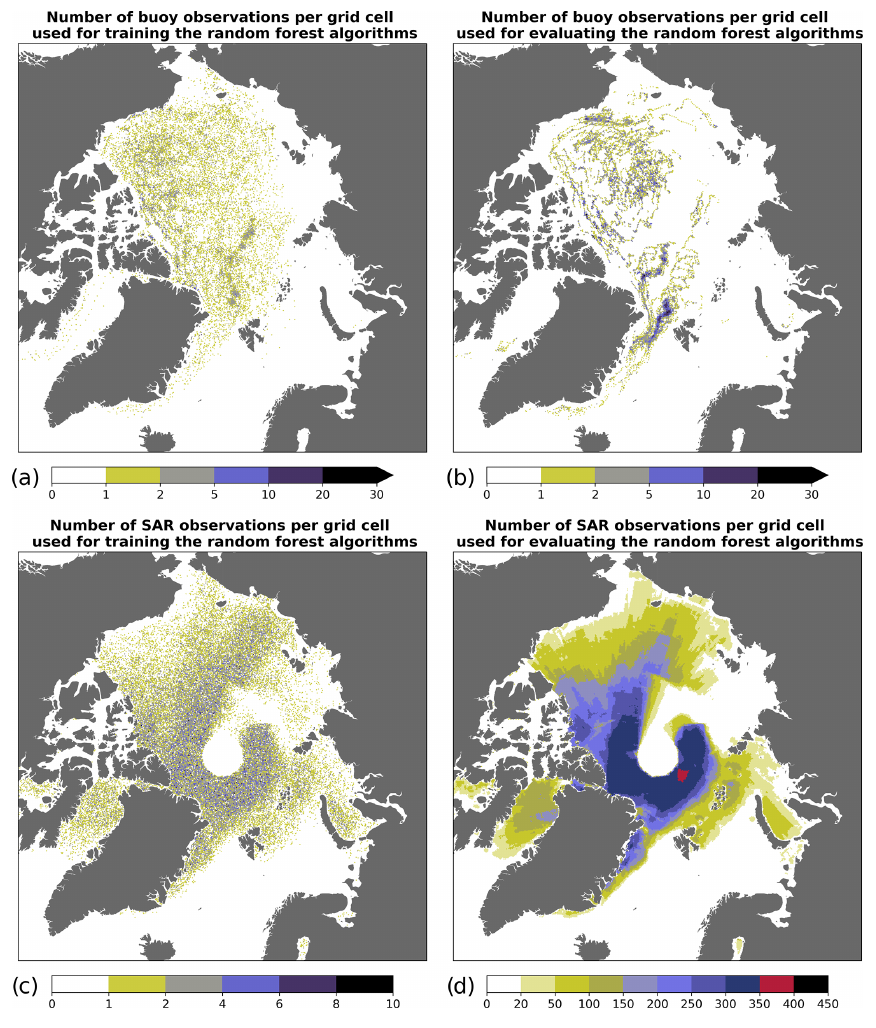
Figure 1. (a) Number of buoy observations per grid cell used for training the random forest algorithms during the period from June 2013 to May 2020. (b) Number of buoy observations per grid cell used for evaluating the random forest algorithms during the period from June 2020 to May 2021. (c) Number of SAR observations per grid cell used for training the random forest algorithms during the period from January 2018 to May 2020. (d) Number of SAR observations per grid cell used for evaluating the random forest algorithms during the period from June 2020 to May 2021. These four maps show the number of observations for a lead time of 1d (similar results have been found for other lead